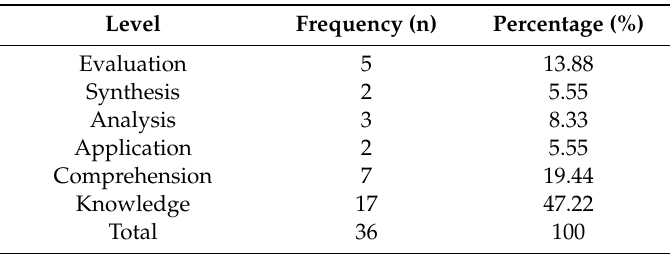
Table 6. Frequency (n) and percentage (%) of cognitive demand levels according to Bloom’s taxonomy for the concept of water (Baccalaureate).